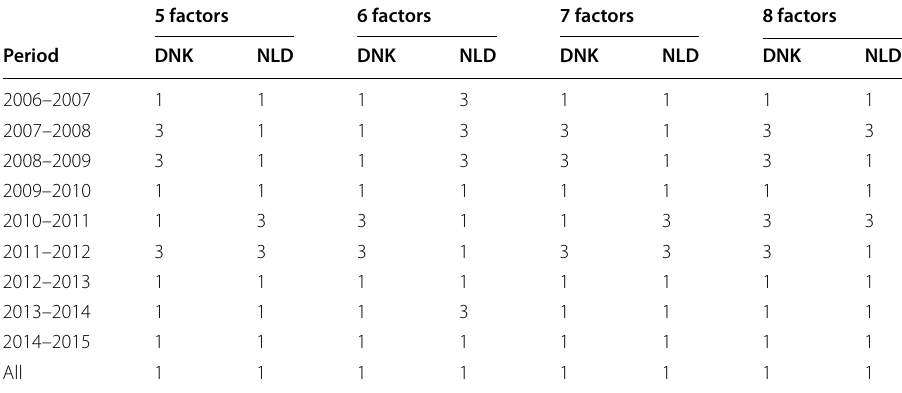
Table 5 Best-performing shortcuts to the complete additive SDA, by measured distance to the aggregate true results